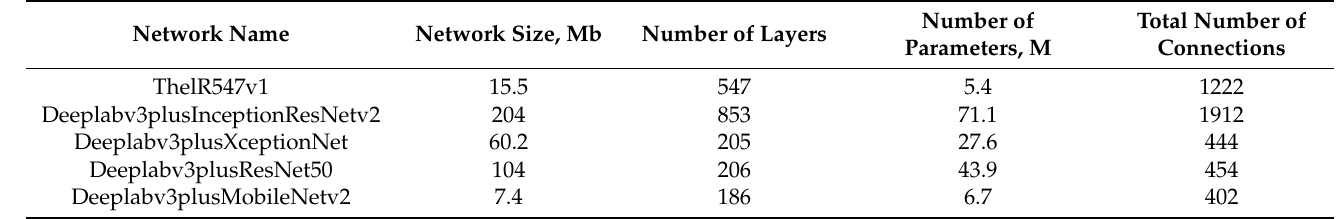
Table 8. Comparison between the proposed ThelR547v1 and other pretrained